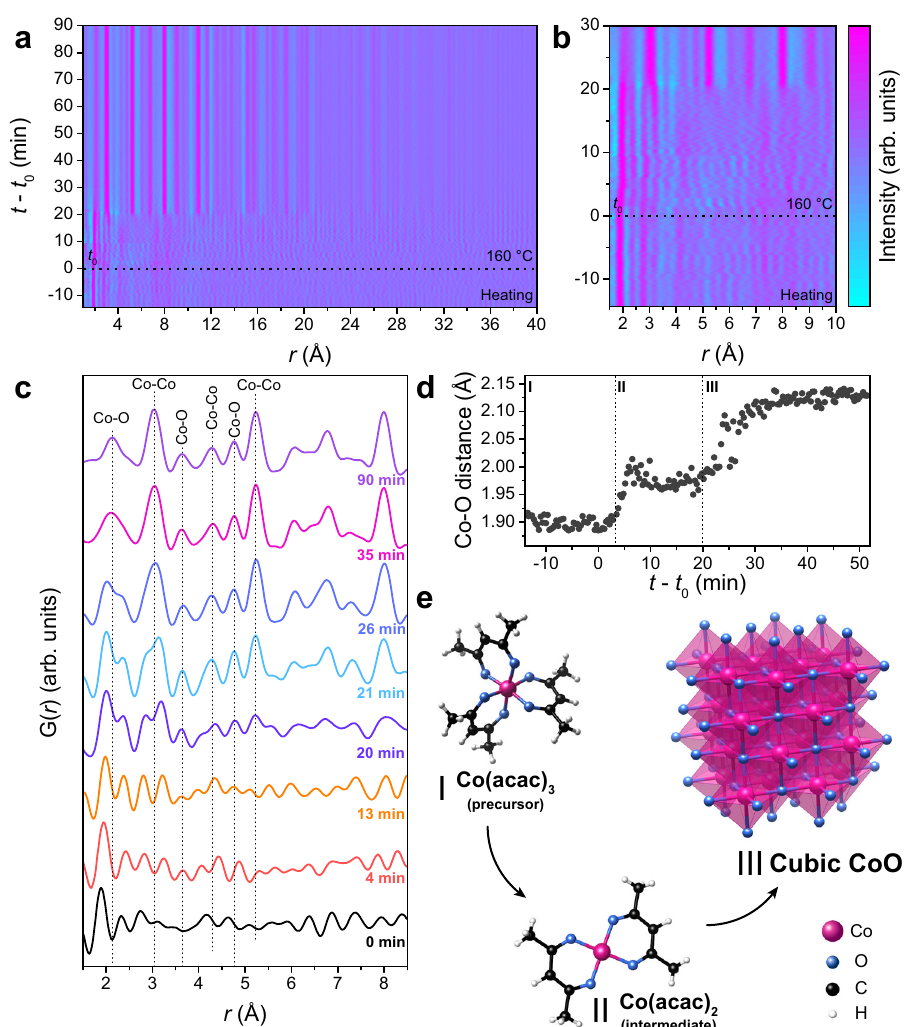
Fig. 4 Following the structural rearrangement of the Co complex and the crystallization of CoO. a In situ time-resolved PDFs G( r ) for the CoO synthesis. The heating step includes heating from room temperature to 60 °C, 5 min at 60 °C, and heating from 60 to 160 °C. We set t 0 (beginning of reaction time) to the point when we start heating to 160 °C. b Region of a illustrating the short-range order before the crystallization of CoO. c Zoom into the local order region of the PDFs for selected reaction times of the in situ data. Dashed lines show the fi rst coordination shells of CoO. d Changes in the shortest Co – O bond over the reaction course, which indicate three reaction stages. e Structural models for the proposed reaction stages. The structures were obtained from the crystallographic data from references 63,74,75 using the VESTA software 76